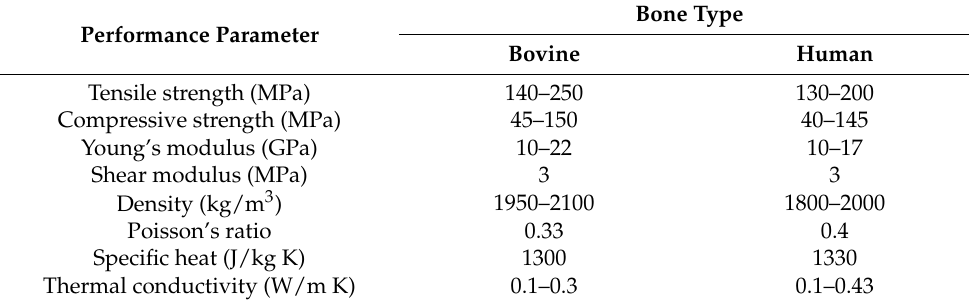
Table 1. Performance parameters of bovine bone and human bone